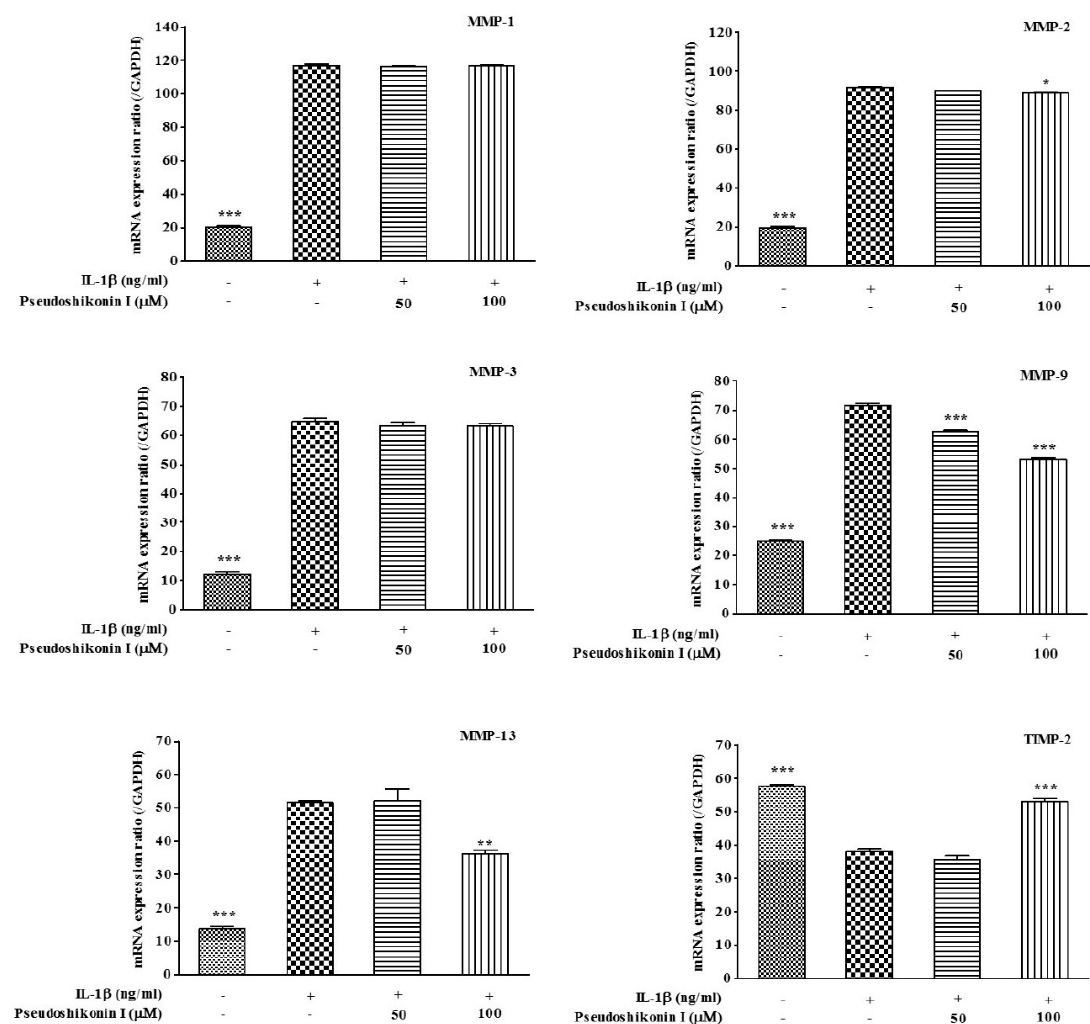
Figure 3. Effect of pseudoshikonin I on the gene expression of MMP-1, 2, 3, 9, 13, and TIMP-2 in IL-1 β -induced SW1353 cells by RT-PCR. SW1353 cells incubated in the presence of 50 or 100 µ M pseudoshikonin I stimulated with 20 ng/mL of IL-1 β for 24 h. GAPDH was used as internal control. Values were expressed as means ± S.D. of triple experiments. * p < 0.05, ** p < 0.01, *** p < 0.001 compared with IL-1 β treated group (control).